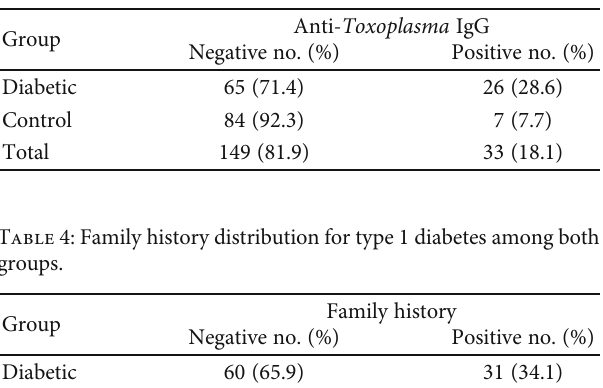
Table 3: Anti- Toxoplasma IgG infection distribution among groups.